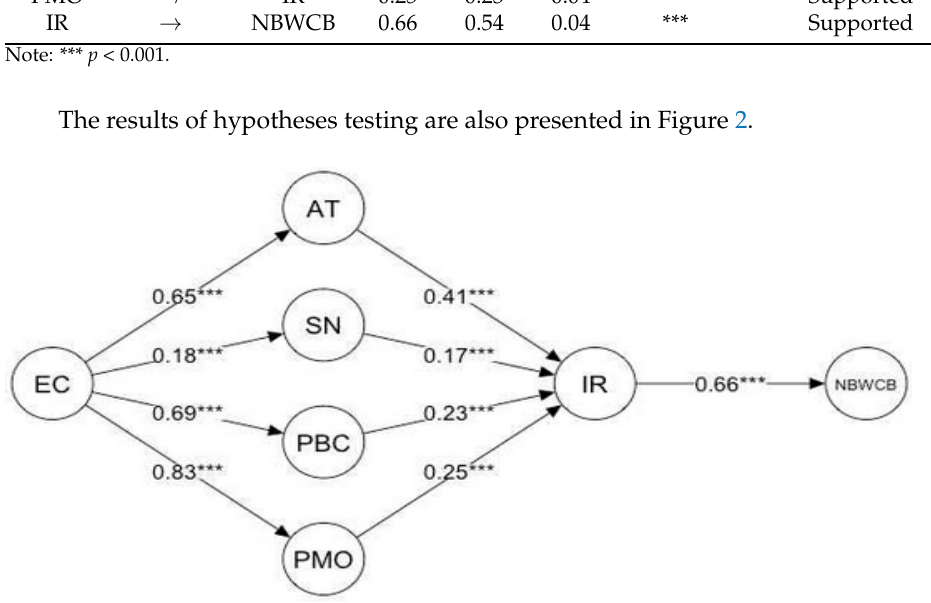
Figure 2. Results of hypotheses testing. Note: *** p < 0.001.